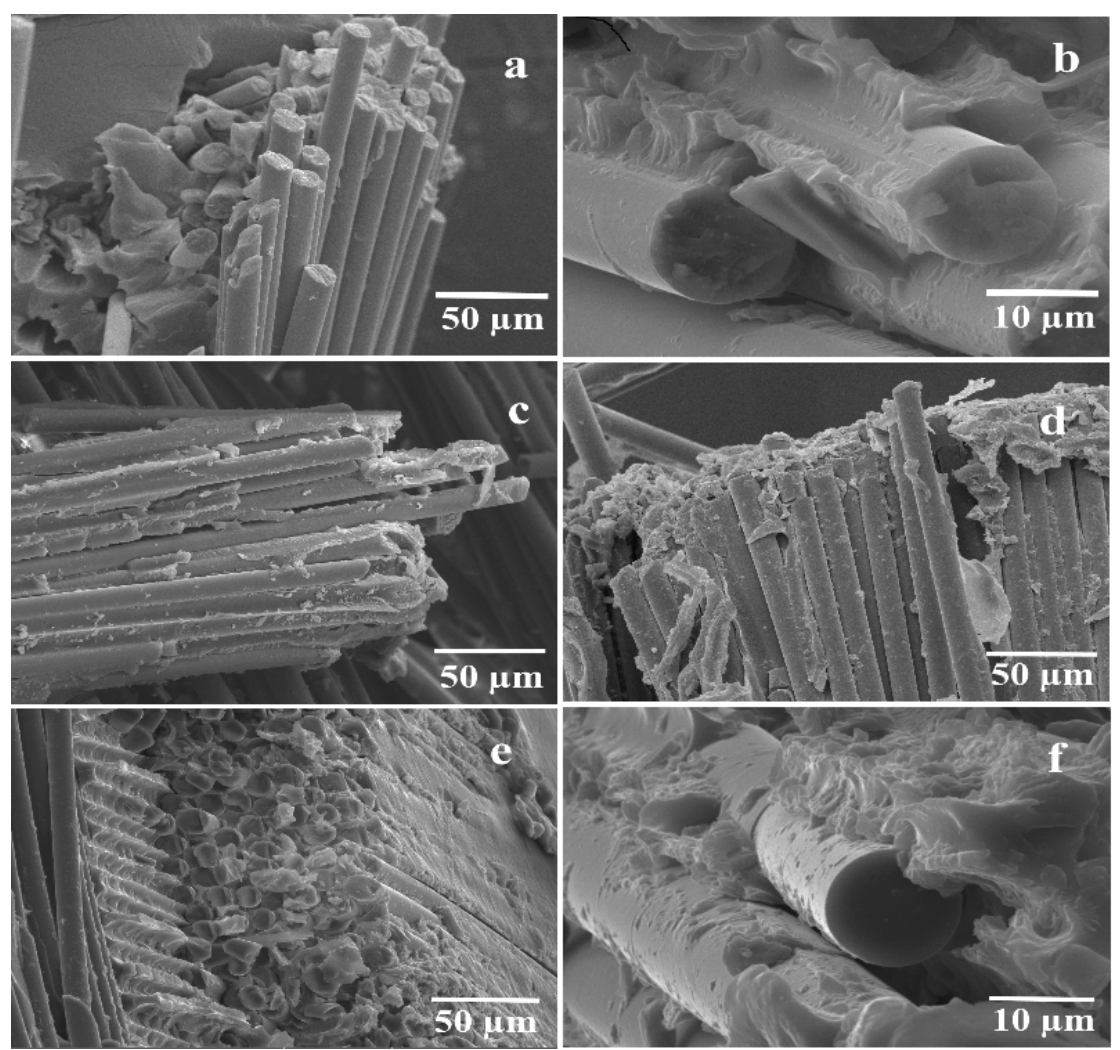
Figure 7. The structure of the fracture surface of the composites: ( a ) 50 / 50 as-received GF; ( b ) 50 / 50 preheated GF; ( c ) 60 / 40 as-received GF; ( d ) 60 / 40 preheated GF; ( e ) 70 / 30 as-received GF, and ( f ) 70 / 30 preheated GF composites.